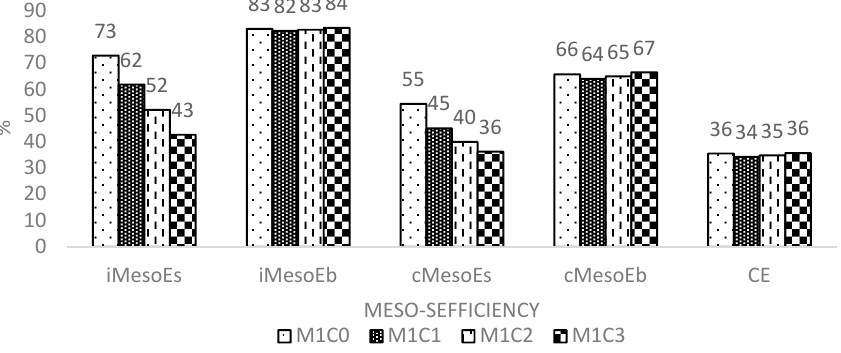
Figure 10. Sefficiency for M1C.